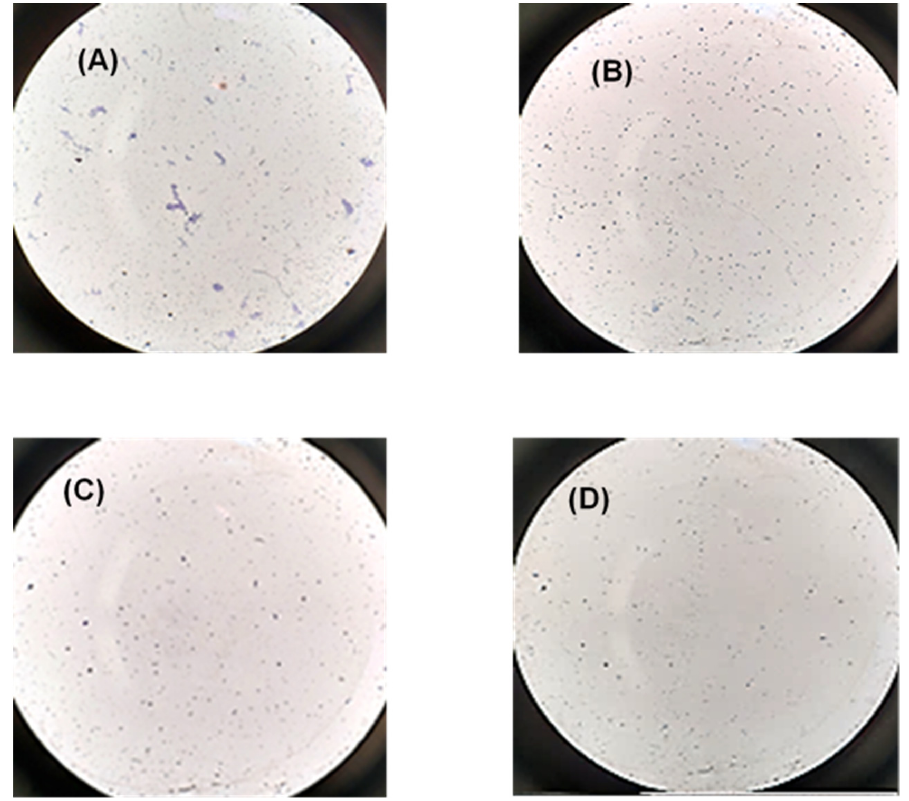
Figure 7. Representative microscopy images of platelet aggregation after staining with Giemsa dye in the following conditions: ( A ) PRP incubated with CaCl 2 for 30 min (positive control); ( B ) PRP incubated with WFI (negative control); ( C ) PRP incubated with 50 μ g/mL of PRP during 30 min; ( D ) PRP incubated with 50 μ g/mL of PRP for 4 h. Microscope objective: 40×. Activated partial thromboplastin time (APTT) values were in the range considered clinically normal (20–40 s), showing a slight decrease in the values at 30 min ( p > 0.05, ANOVA) and 4 h ( p > 0.05, ANOVA) in comparison with the control group, as can be seen in Figure 8A). Prothrombin time (PT) showed values in the reference range (12–15 s), with a slight increase after 30 min of incubation ( p > 0.05) and 4 h ( p > 0.05, ANOVA) compared to controls (Figure